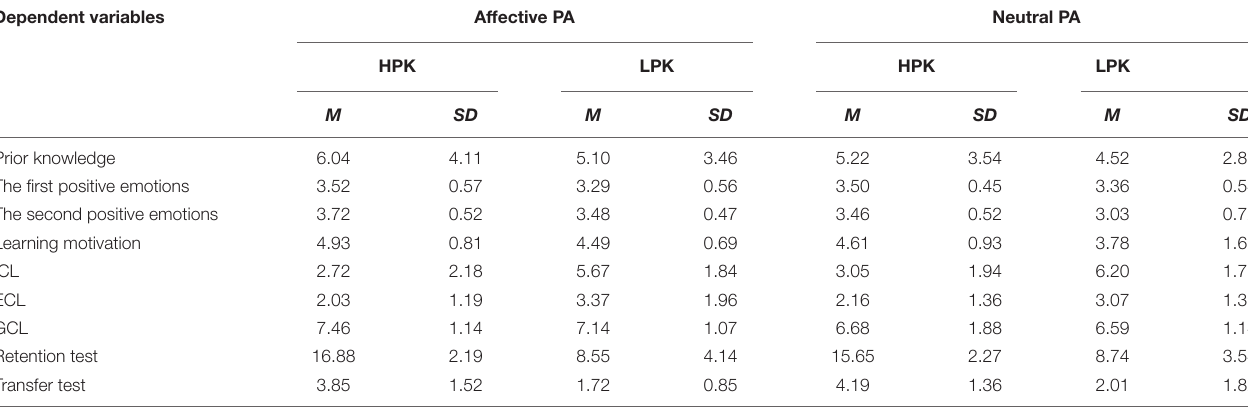
TABLE 3 | Means and standard deviations of all tests for four groups in Experiment 3. Dependent